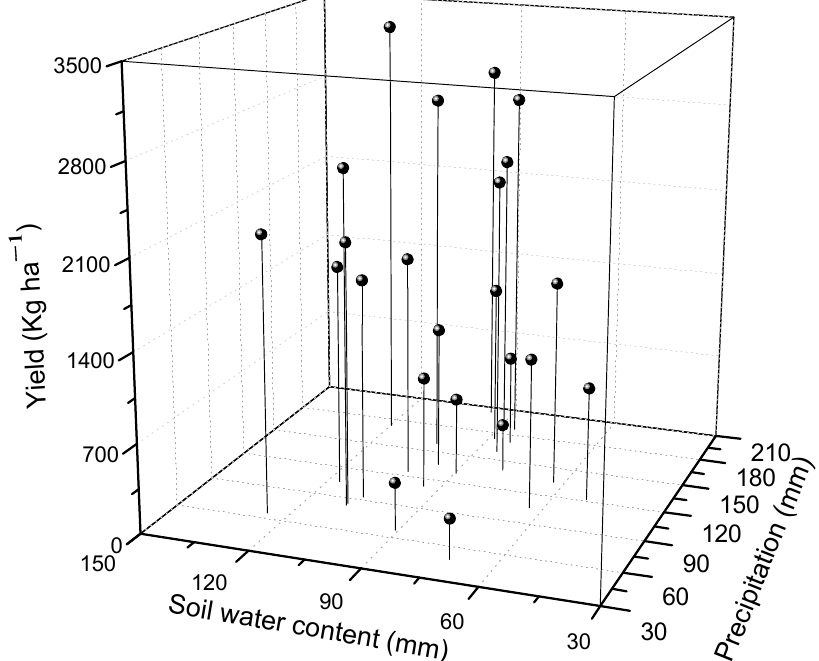
Figure 3. Spring wheat yield associated with soil water content at planting and precipitation during the spring wheat growing season at Dingxi, Gansu Province, China.